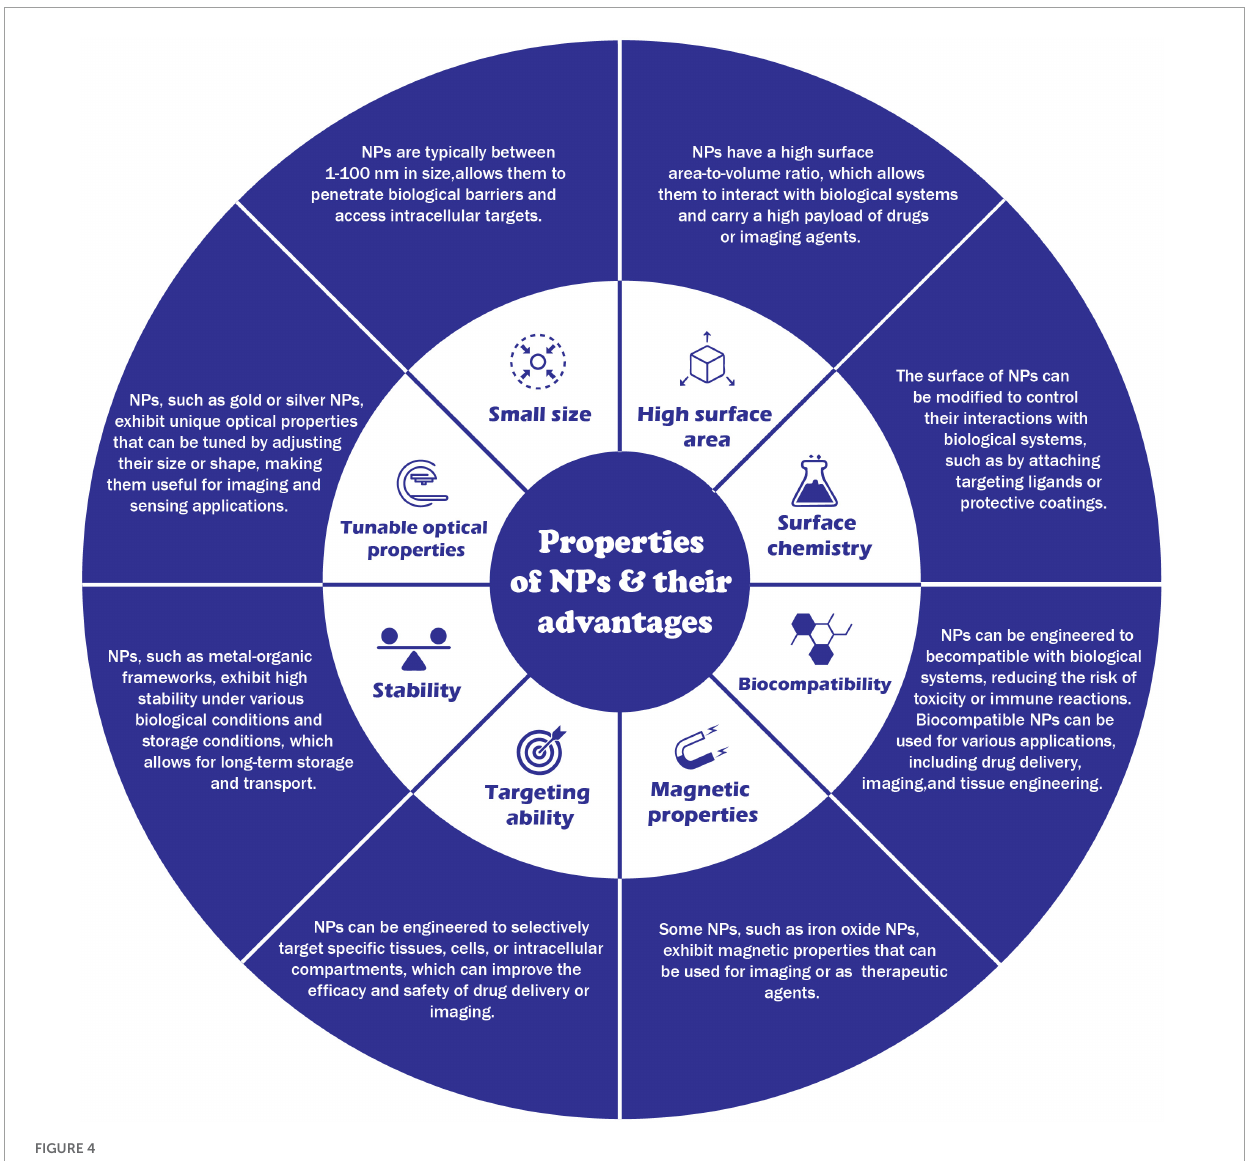
FIGURE4 Properties of nanoparticals and their advantages.